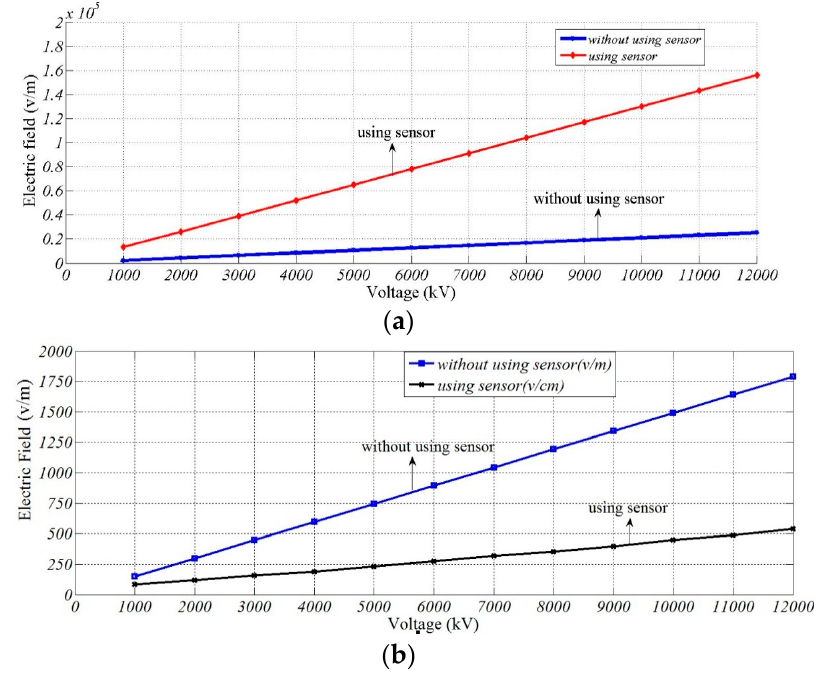
Figure 18. Fitting curve of electric field intensity and voltage grade: ( a ) phase A; and ( b ) phase B. Least-square fitting is conducted for electric field intensity data at A and B acquired before and after sensor is introduced, and Equations (18) and (19) are obtained, where x means electric field intensity of A and B before using the sensor, and y means electric field intensity of A and B after using the sensor. In the equation the constant term is generated under the combined action of boundary condition setting and fitting method when simulation model is established.